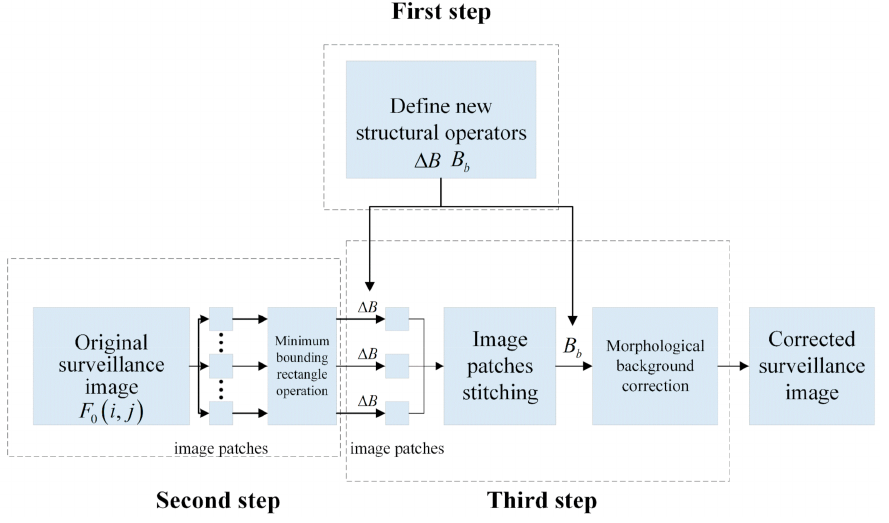
Figure 1. Flowchart of the proposed IBSGM